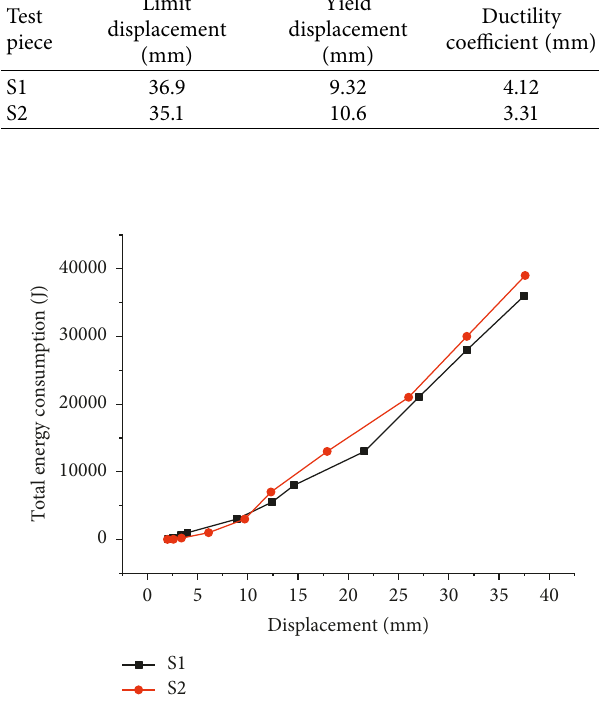
Figure 9: Comparison of energy dissipation